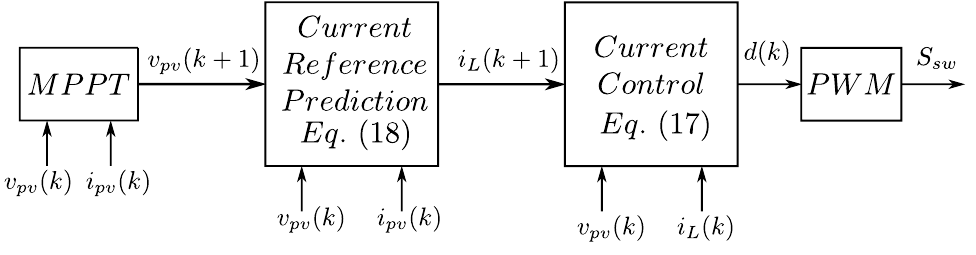
Figure 8. Block diagram of the FCS predictive controller scheme for the DC/DC boost converter proposed in